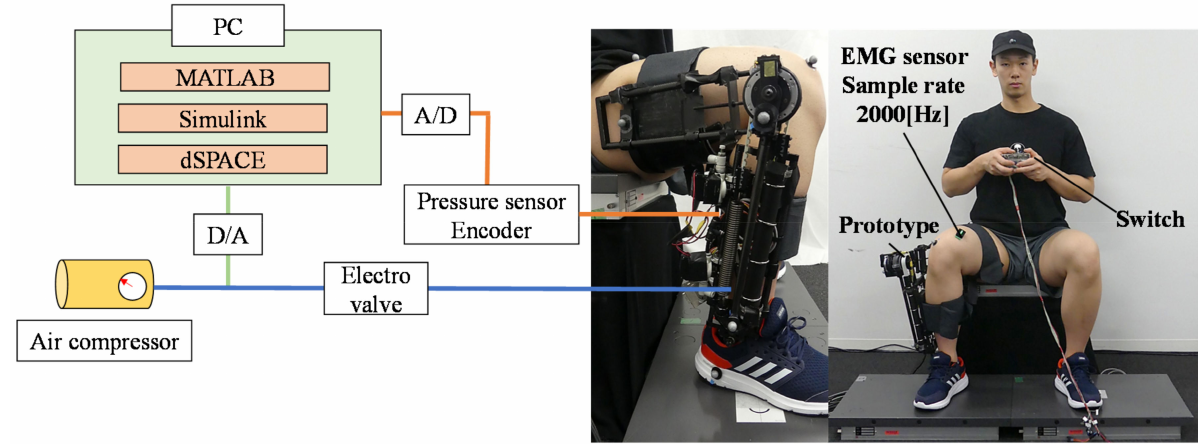
Figure 10. Experimental environment in the assist evaluation of the standing-up